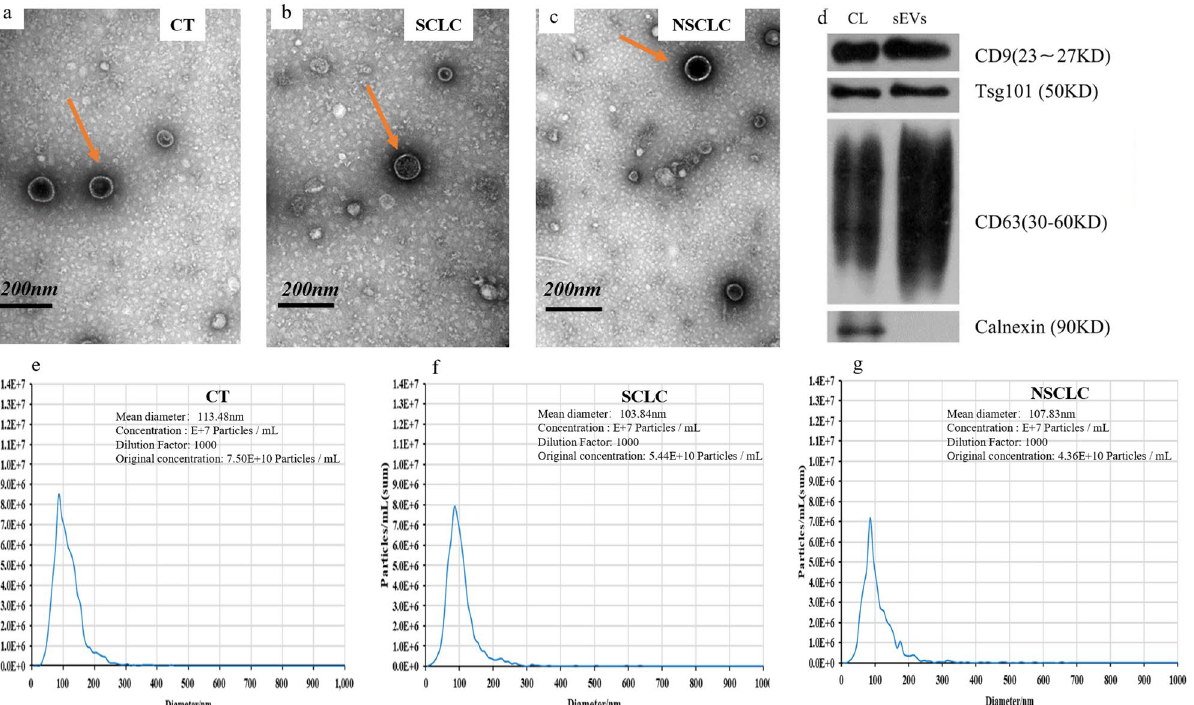
Figure 2. Isolated sEV-enriched fractions from participants’ plasma ( a – c ) TEM images showing that sEVs of three groups are oval or bowl-shaped capsules without a nucleus. d. The Western blot analysis of sEVs, markers CD9, CD63and TSG101were all detected in the sEV-enriched fractions isolated from plasma, and Calnexin, a negative marker of sEVs was absent in our isolated sEVs-enriched fraction samples. ( e – g ) NTA showed that the diameter and concentration of EVs for three groups. CL, control cell